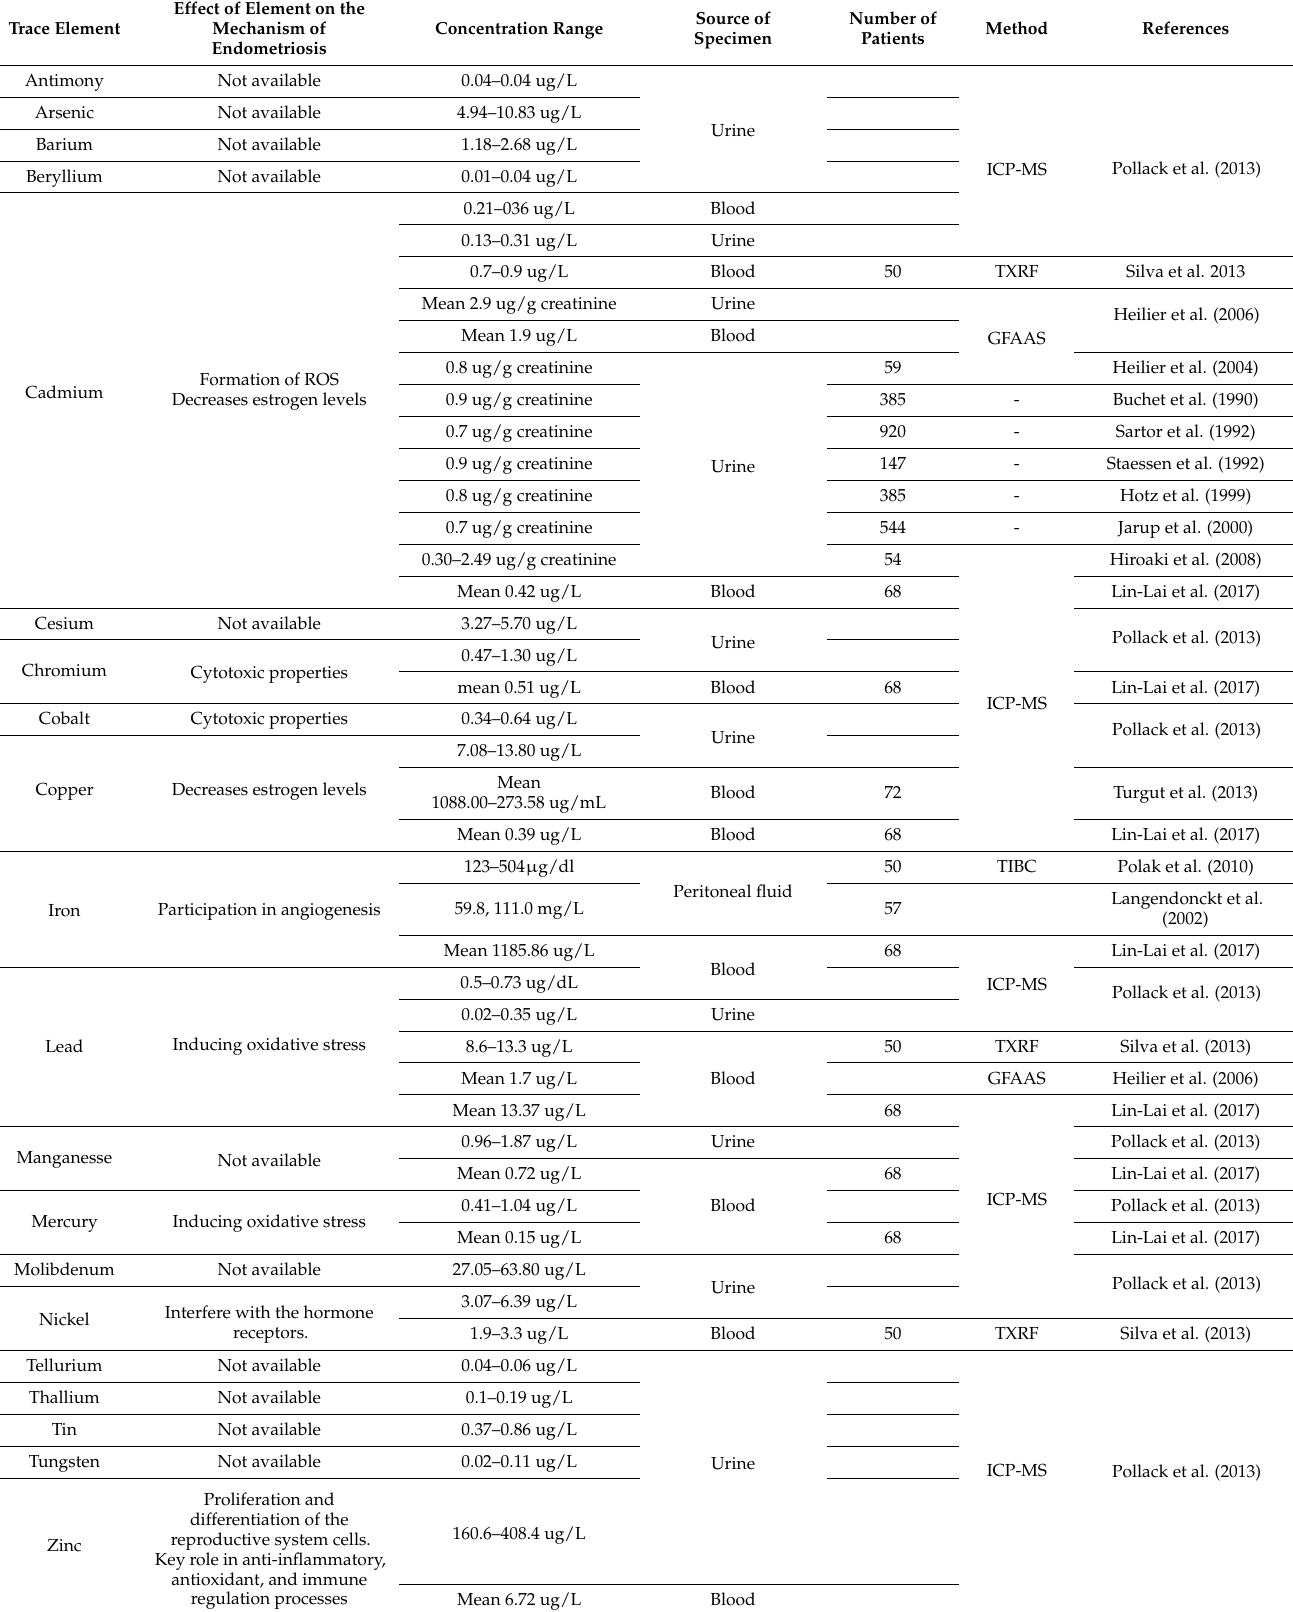
Table 1. Concentration of trace elements in patients with